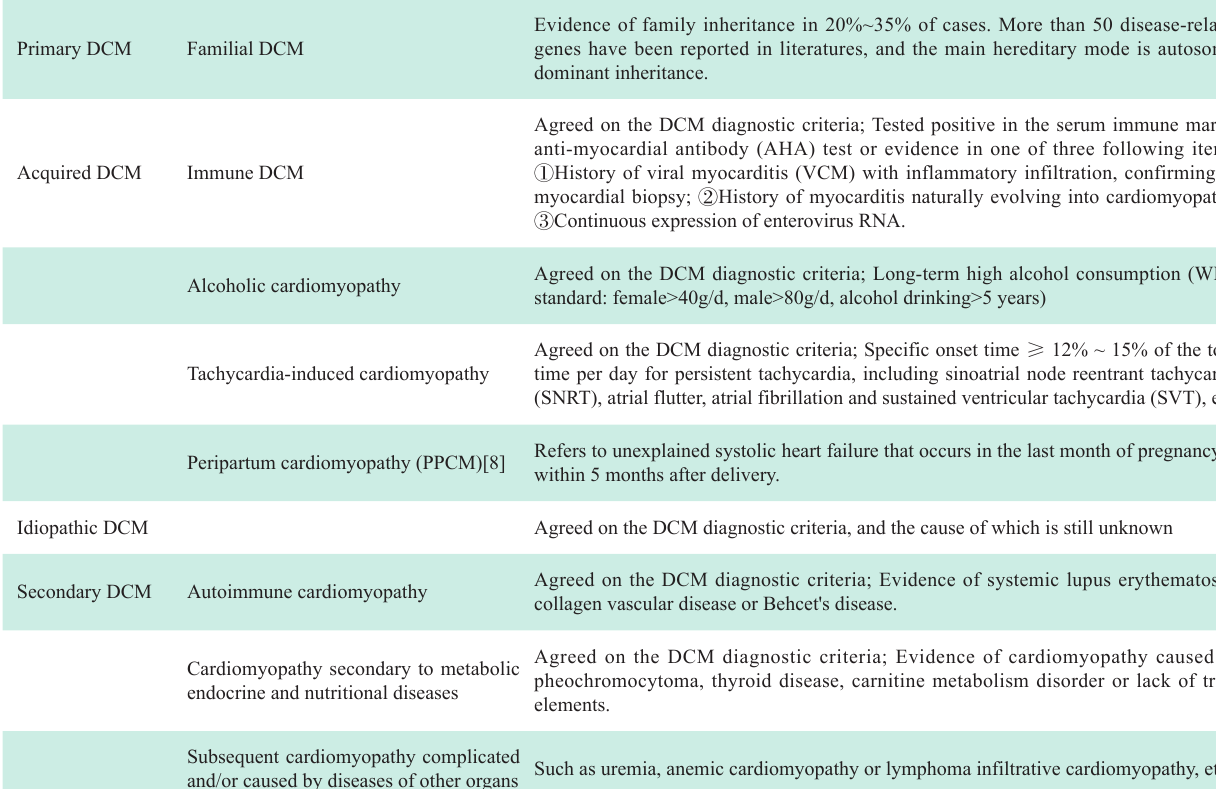
Table 1 The main causes of dilated cardiomyopathy Primary